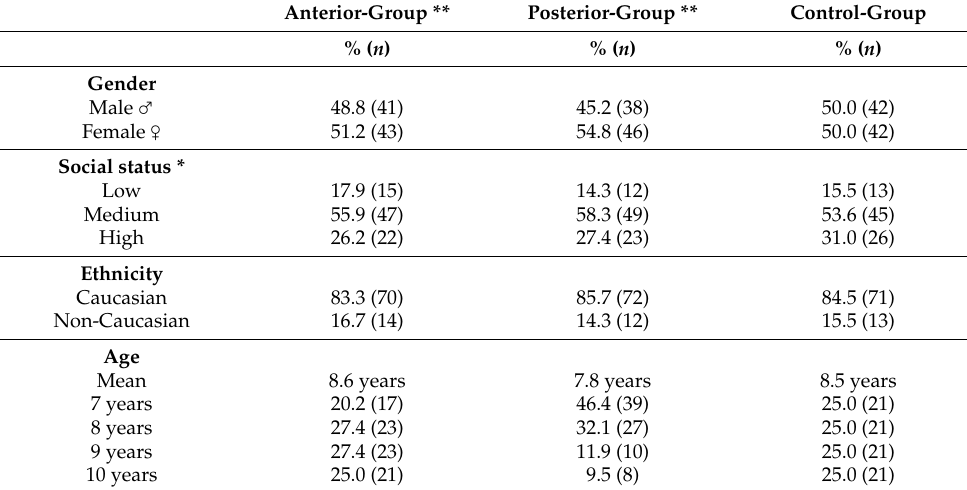
Table 1. Summary of Sample Data ( n = 252